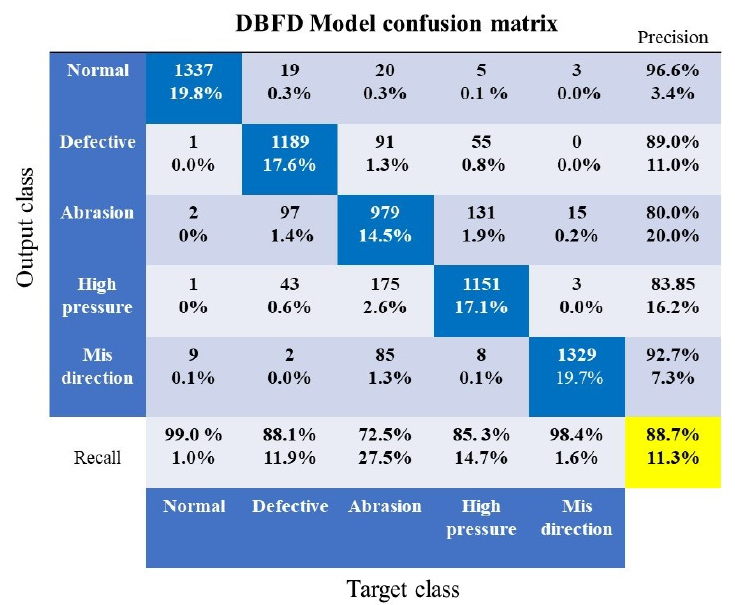
Figure 9. A confusion matrix used to evaluate the prediction abilities of the drill bit failure detection model on test data.